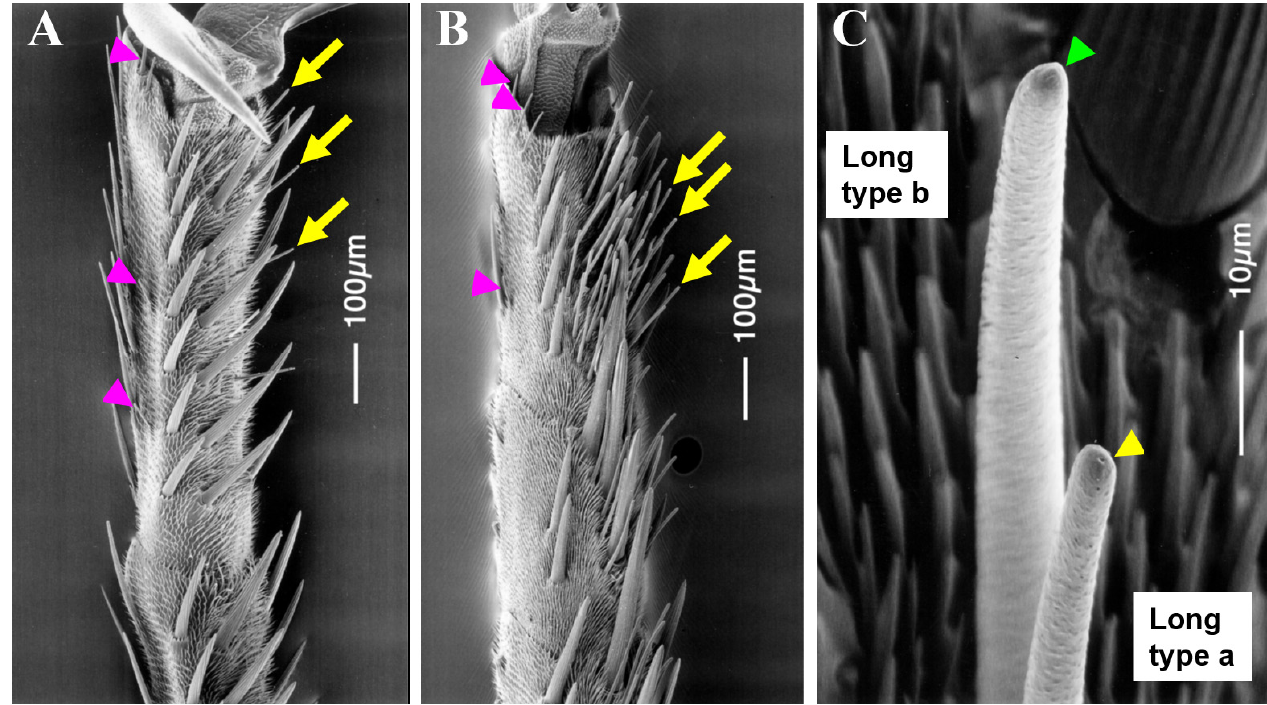
Figure 1. Scanning electron micrographs of contact chemosensilla of the fifth tarsomeres in the fore ‐ legs of adult Atrophaneura alcinous . ( A ) Ventral side of the fifth tarsomere in the male. ( B ) Ventral side of the fifth tarsomere in the female. Arrows and arrowheads indicate long ‐ and short ‐ type sen ‐ silla, respectively, in ( A , B ). ( C ) Morphological differences between long ‐ type a sensilla and long ‐ type b sensilla of the fifth tarsomere in the female. Long ‐ type sensilla with a single pore at the tip (yellow arrowhead) and long ‐ type b sensillum with a small protuberance at the tip (green arrow ‐ head).